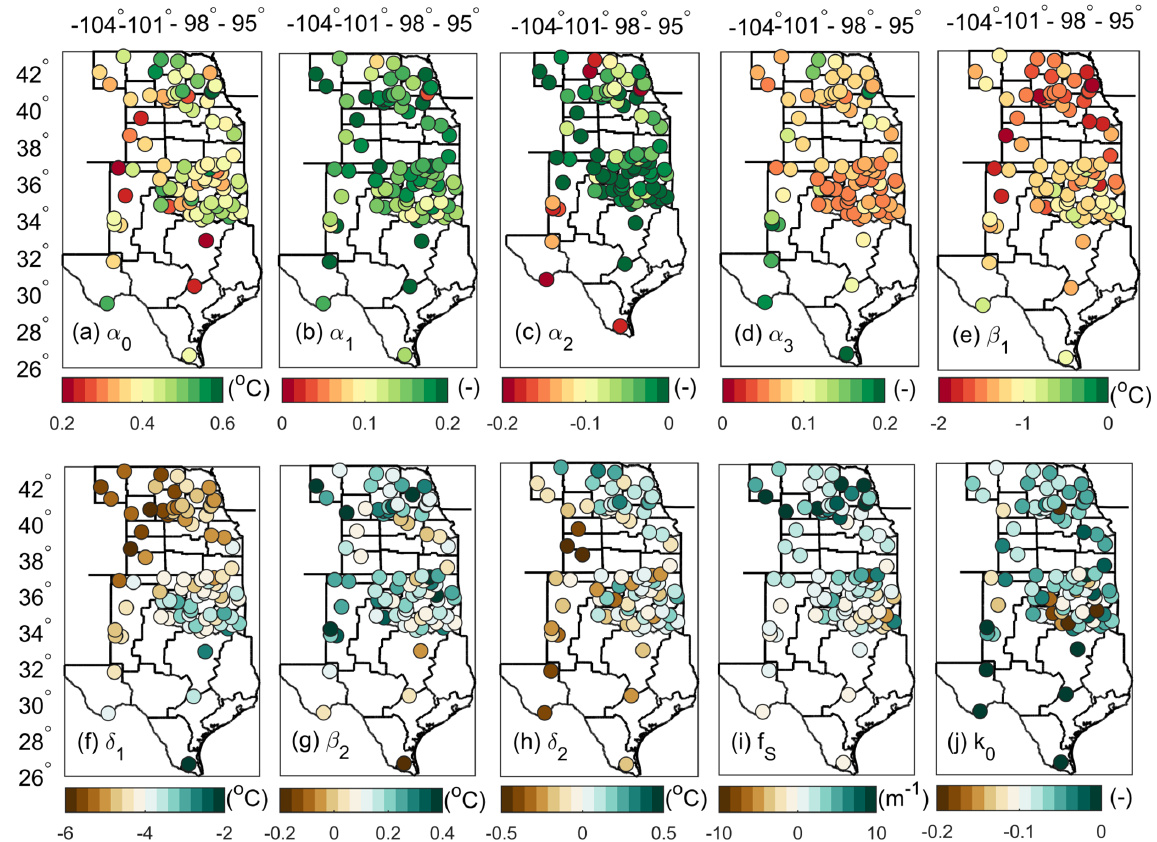
Figure 4. Spatial variations in the improved empirical model (iEM) coefficients are as follows: (a–d) for α 0 , α 1 , α 2 , and α 3 ; and (e–h) for β 1 , δ 1 , β 2 , and δ 2 . Panel (i) shows the snow damping ratio ( f s ) and (j) the soil damping ratio coefficients ( k 0 ). The color bar defines the values of the model’s